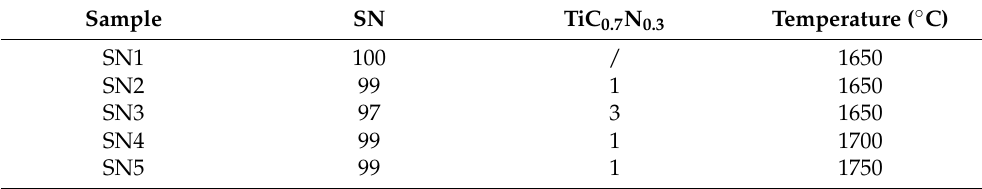
Table 1. Starting powder composition (vol%) and sintering